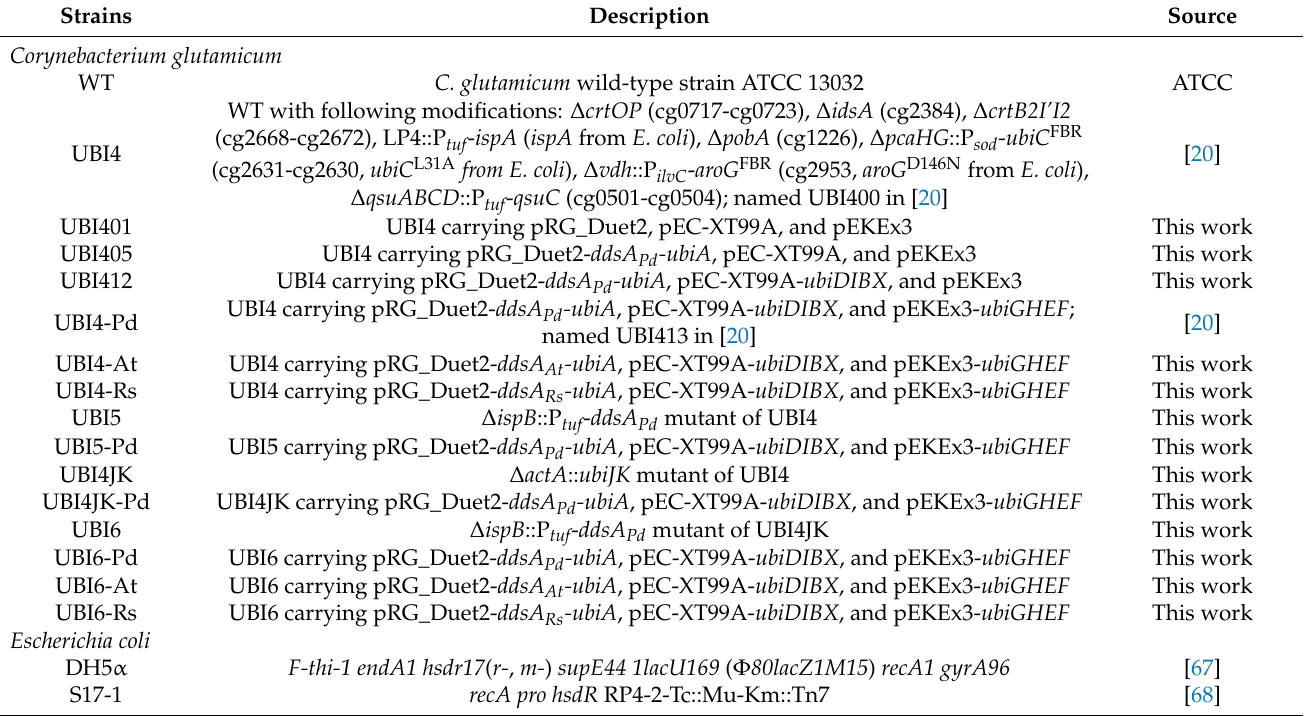
Table 4. Bacterial strains used in this